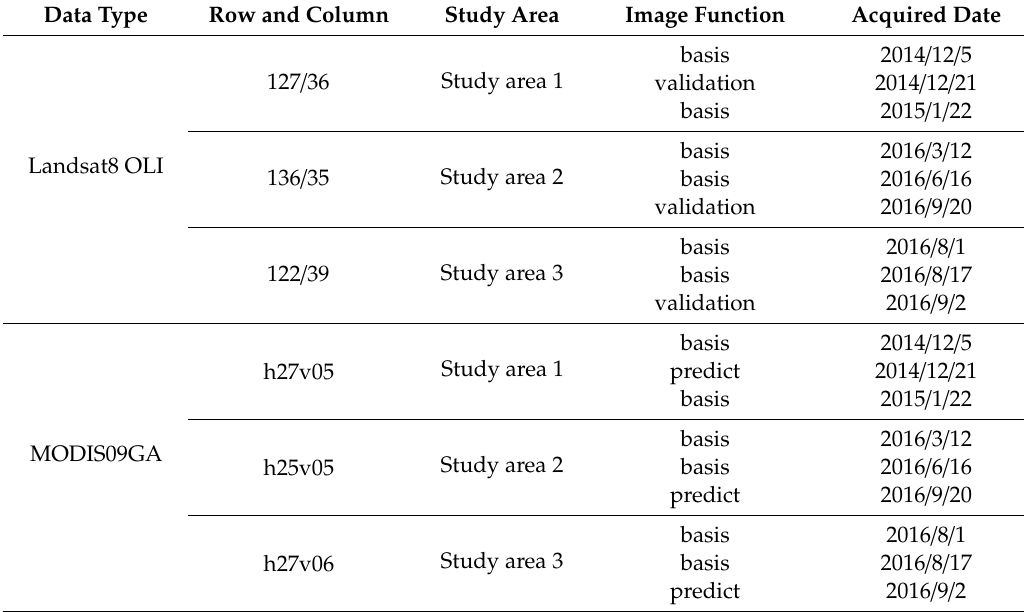
Table 1. Image data and acquisition time.